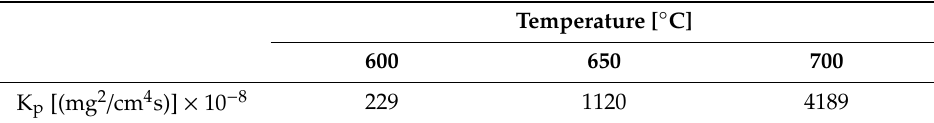
Table 3. Values of the parabolic rate constant for oxidation, K p